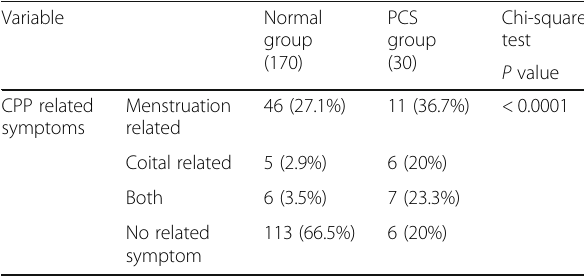
evaluation of patients with chronic pelvic pain to detect the cause with the ability to diagnose pelvic congestion syndrome and so it can guide the clinician for further management.